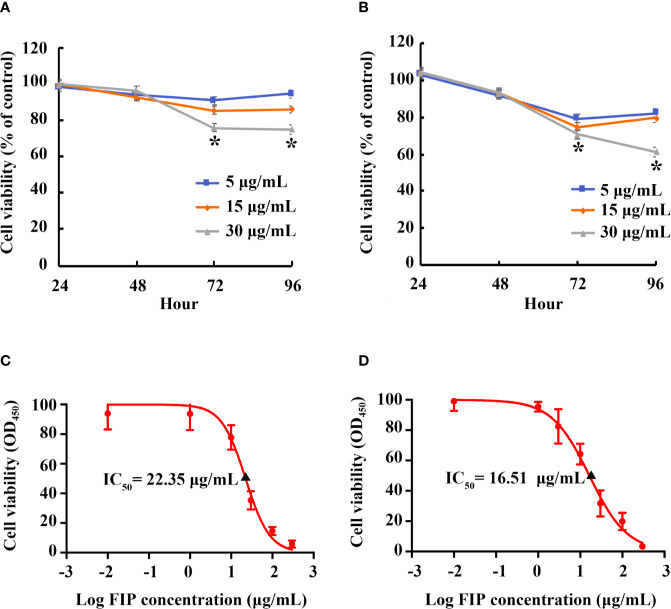
Effects of rFIP-mco on A549 and HepG2 cell proliferation. A549 (A) or HepG2 (B) cells treated with gradient concentrations of rFIP-mco. Cell proliferation was determined by a Cell-Counting Kit-8 assay for 0, 24, 48, 72 and 96 h. *P < 0.05 vs. control groups (untreated cells). IC50 value of rFIP-mco for A549 (C) and HepG2 (D) cells were also determined.